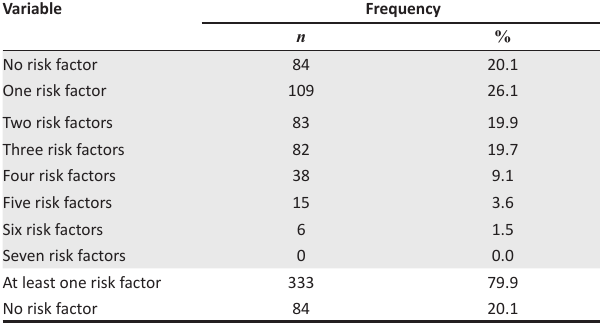
TABLE 4: Proportion of missed opportunities based on number of guideline- recommended specific risk factors for screening.